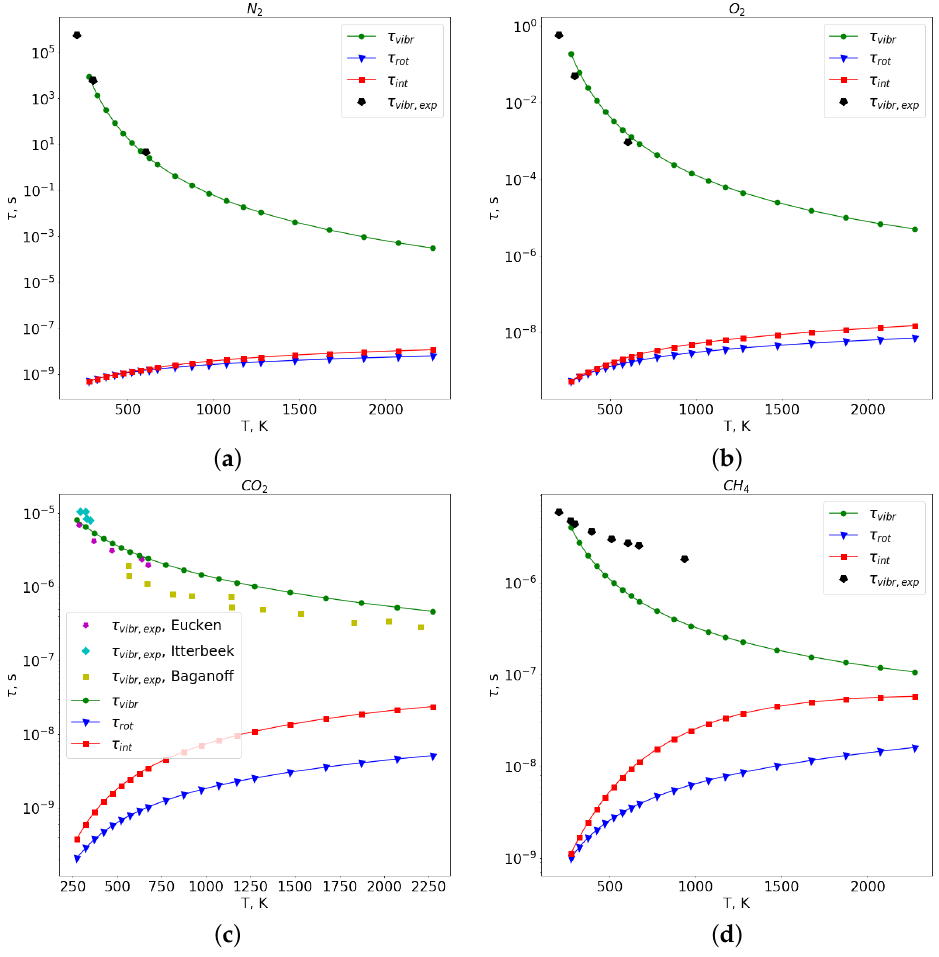
Figure 2. Rotational, vibrational and internal relaxation times for N 2 ( a ), O 2 ( b ), CO 2 ( c ), CH 4 ( d